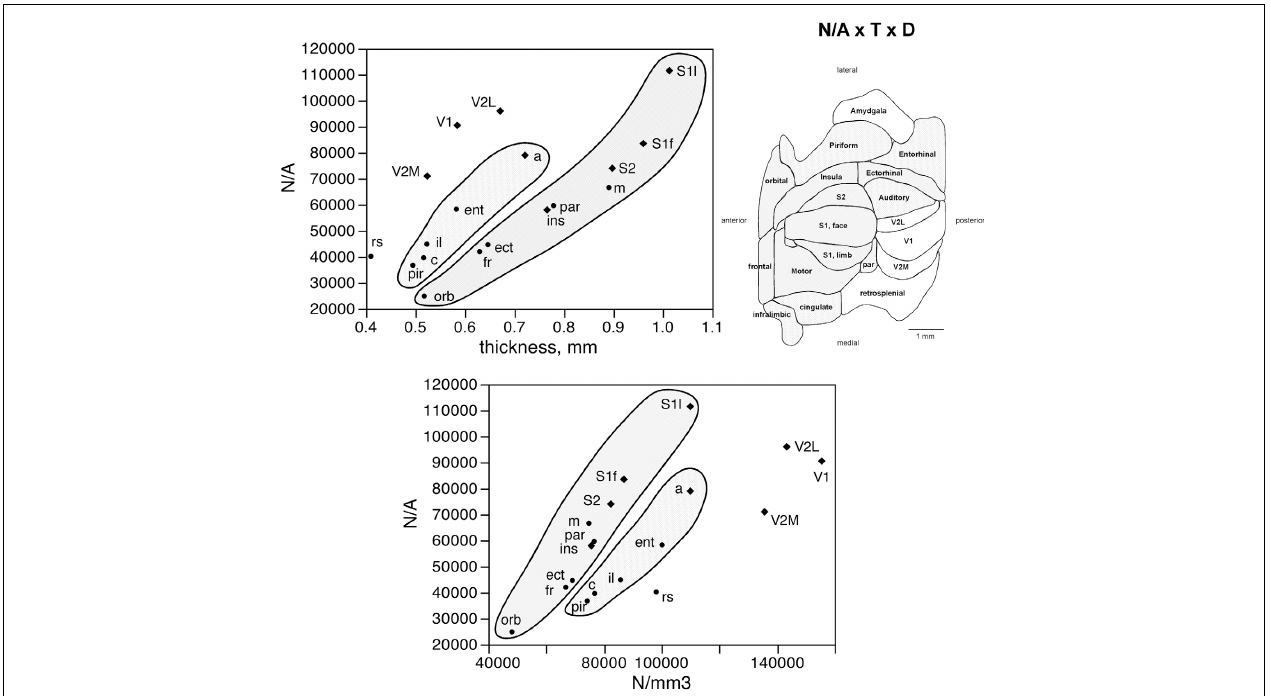
FIGURE 6 | Surface density of neurons (N/A) varies with cortical thickness and neuronal density in different ways across three cortical zones. Top left, average surface density of neurons (N/A, in neurons/mm 2 ) in each functional area plotted as a function of the average thickness of the gray matter in that functional area. Datapoints segregate into three clusters (indicated); within each cluster, variations in N/A are tightly correlated to variations in cortical thickness across functional areas. Top right, shading indicates the clustering of functional